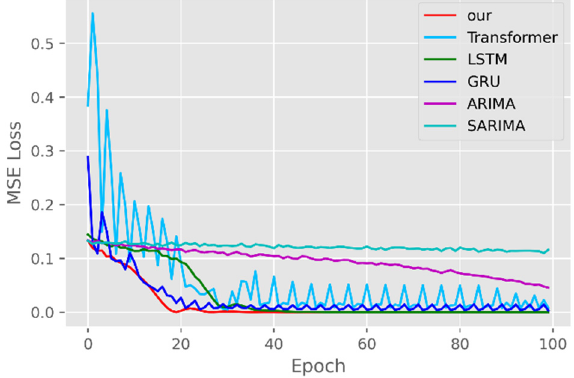
Figure 10. Comparison of training loss for VA cases and deaths.